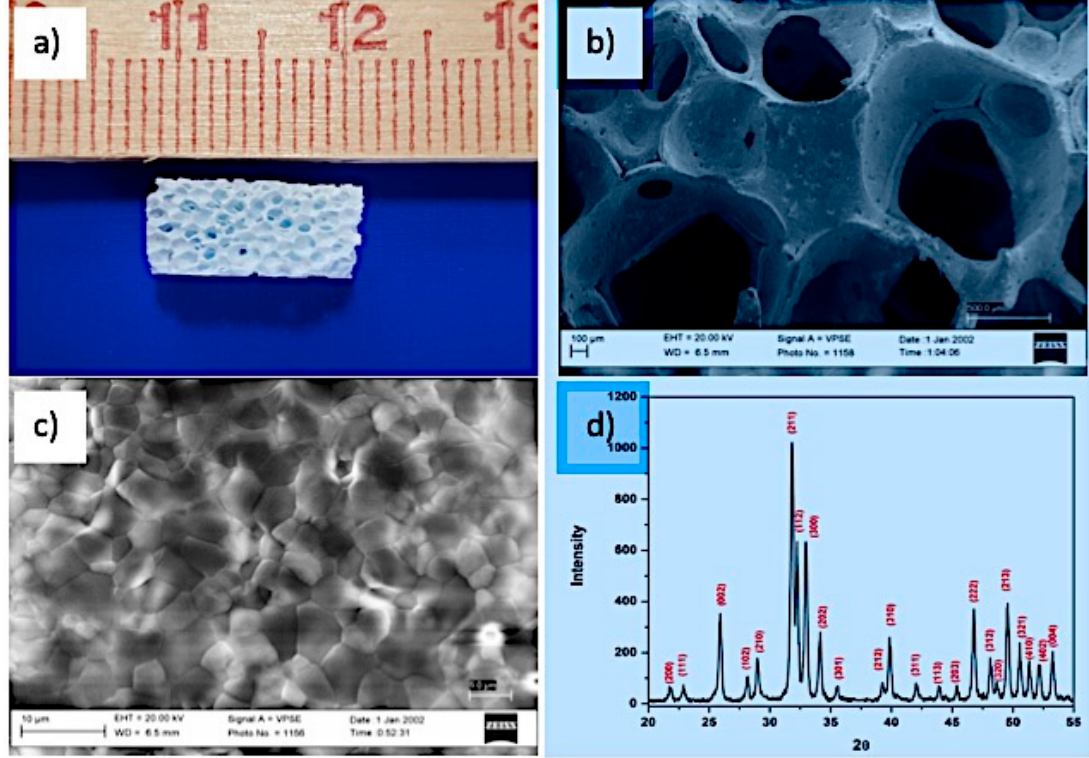
Figure 4. ( a ) A picture of the HA scaffold showing that the sponge replica method was successful in making the HA scaffold, ( b ) the macrostructure of the HA scaffold by SEM reveals that pores are interconnected with an average pore size > 300 microns, ( c ) the microstructure of the HA scaffold by SEM showing a densified structure with well-defined grains having an average grain size < 3 microns without any defects and ( d ) the XRD pattern of the HA scaffold showing a highly crystalline and pure hydroxyapatite phase after sintering the scaffold at 1300 °C.